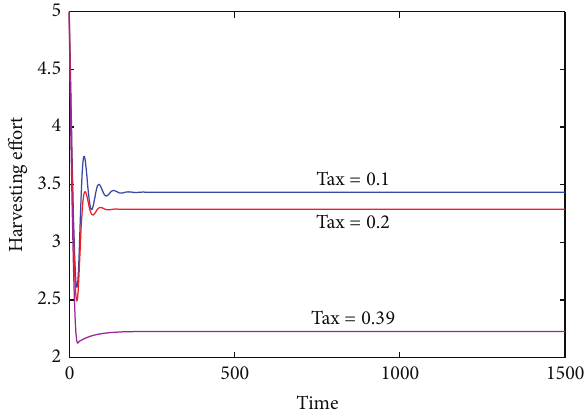
Figure 8: Variation of harvesting effort with time for different tax